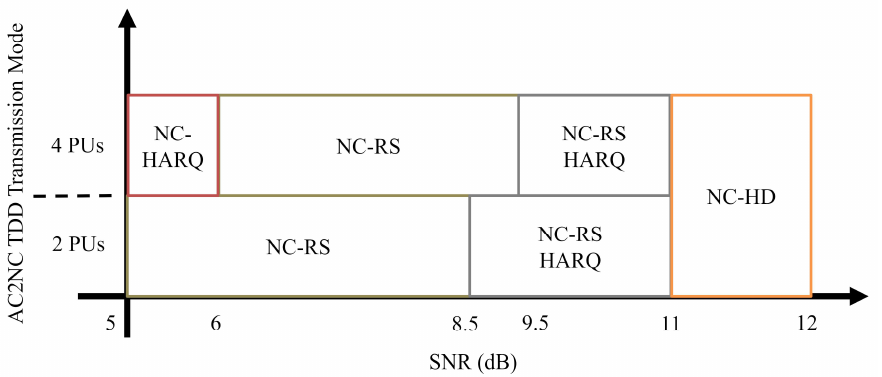
Figure 7. AC2NC TDD transmission